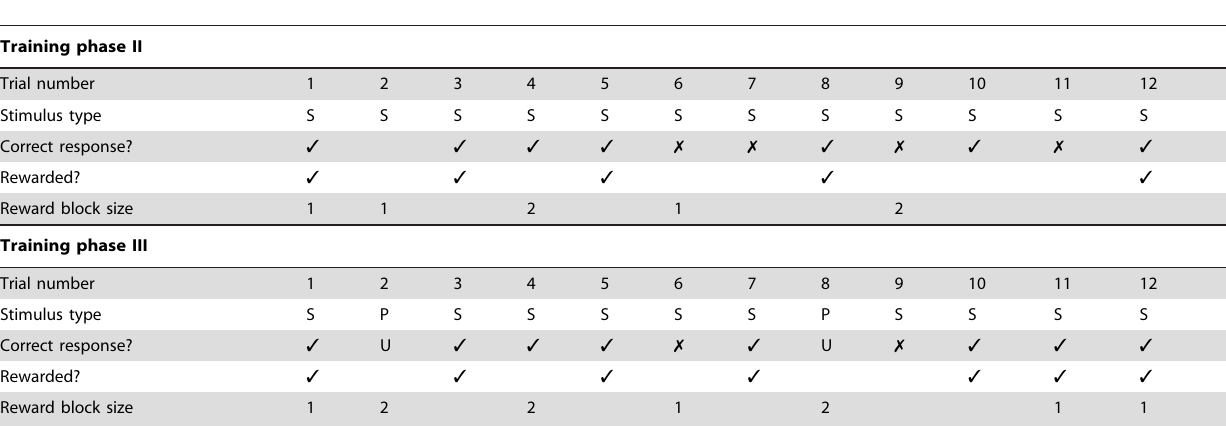
Table 1. Behavioral training and reward scheme for